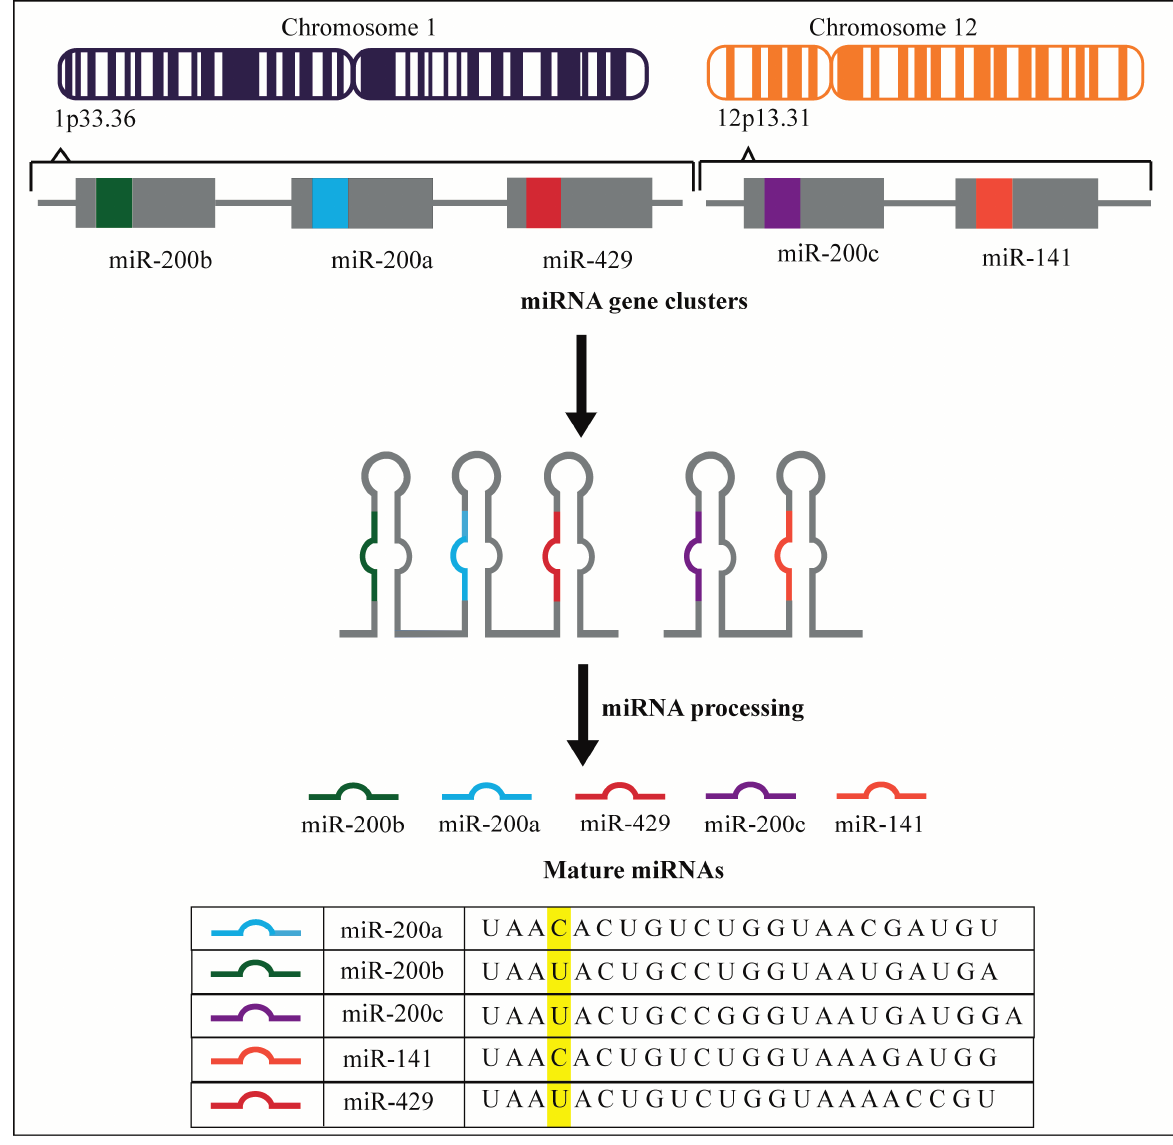
Figure 1. miRNA-200 family arises from two gene clusters: miR-200b, miR-200a and miR-429 from chromosome 1 (1p33.36) while miR-200c and miR-141 from chromosome 2 (12p13.31). The highlight indicates that in the seed sequence (nucleotides 2–8) the difference is only in one